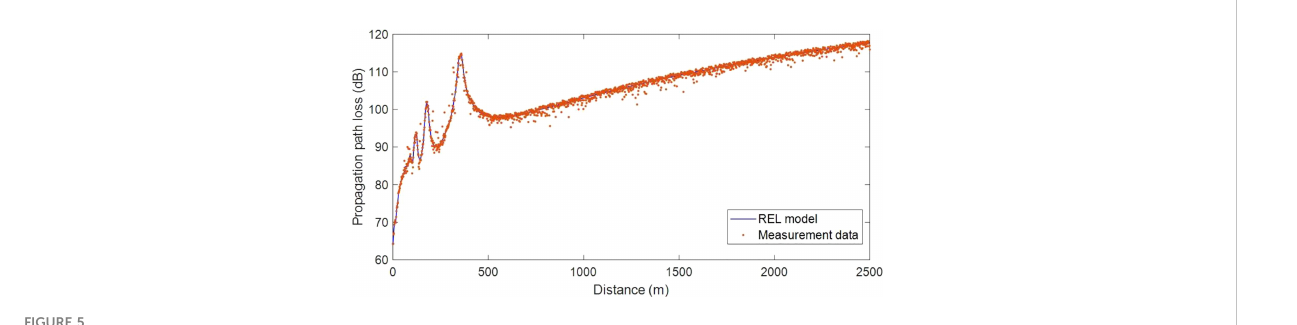
FIGURE 5 Measured propagation path loss compared with the REL model.